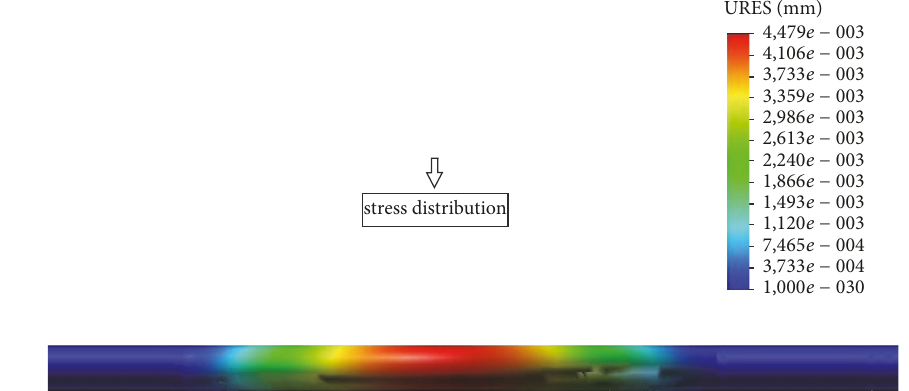
Figure 7: Shaft deformation analysis (50 mm diameter).